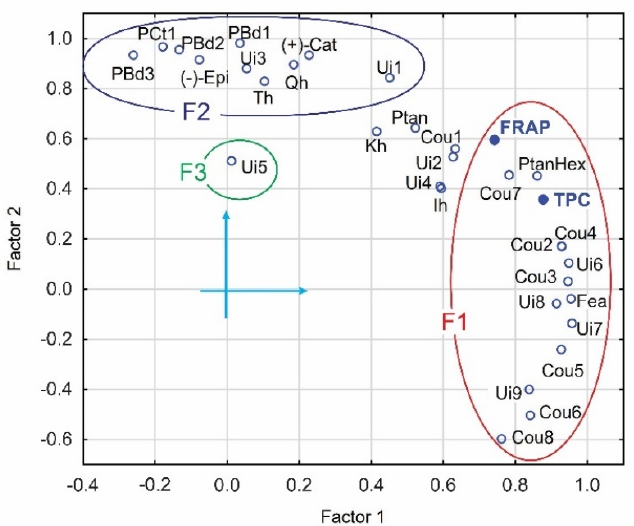
Figure 2. Results of the factor analysis for Norway spruce sample; factor loadings Factor 1 vs. Factor 2. Rotation: Varimax normalized; Extraction: principal components. F1 denotes the group of vectors corresponding to Factor 1, and we use F2 and F3 similarly (see Table 3 as well). For the interpretation of the tags, please refer to Table 1.